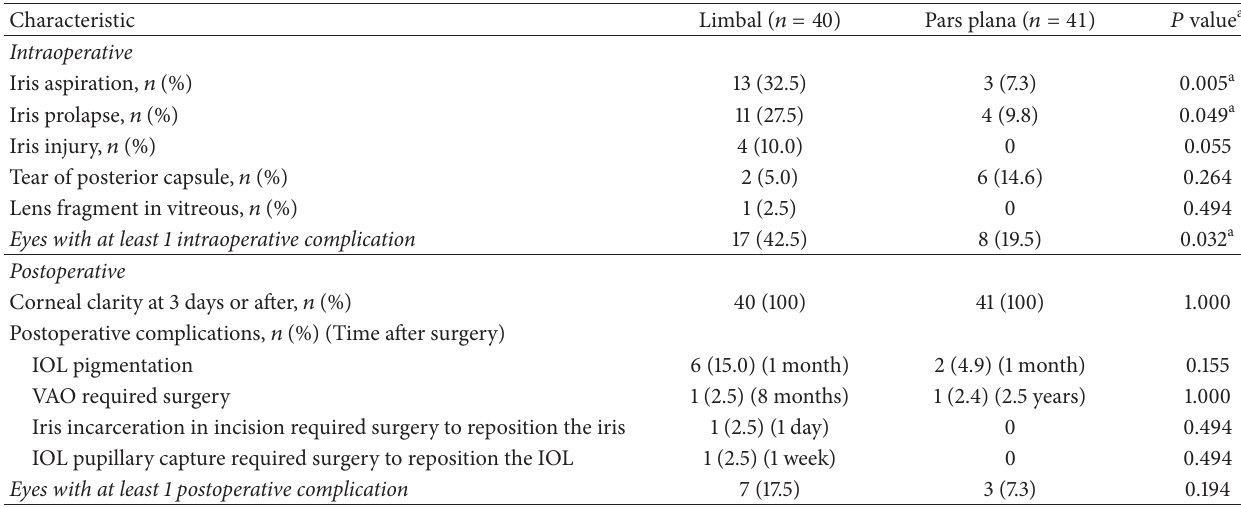
Table 3: Intraoperative and postoperative complications.